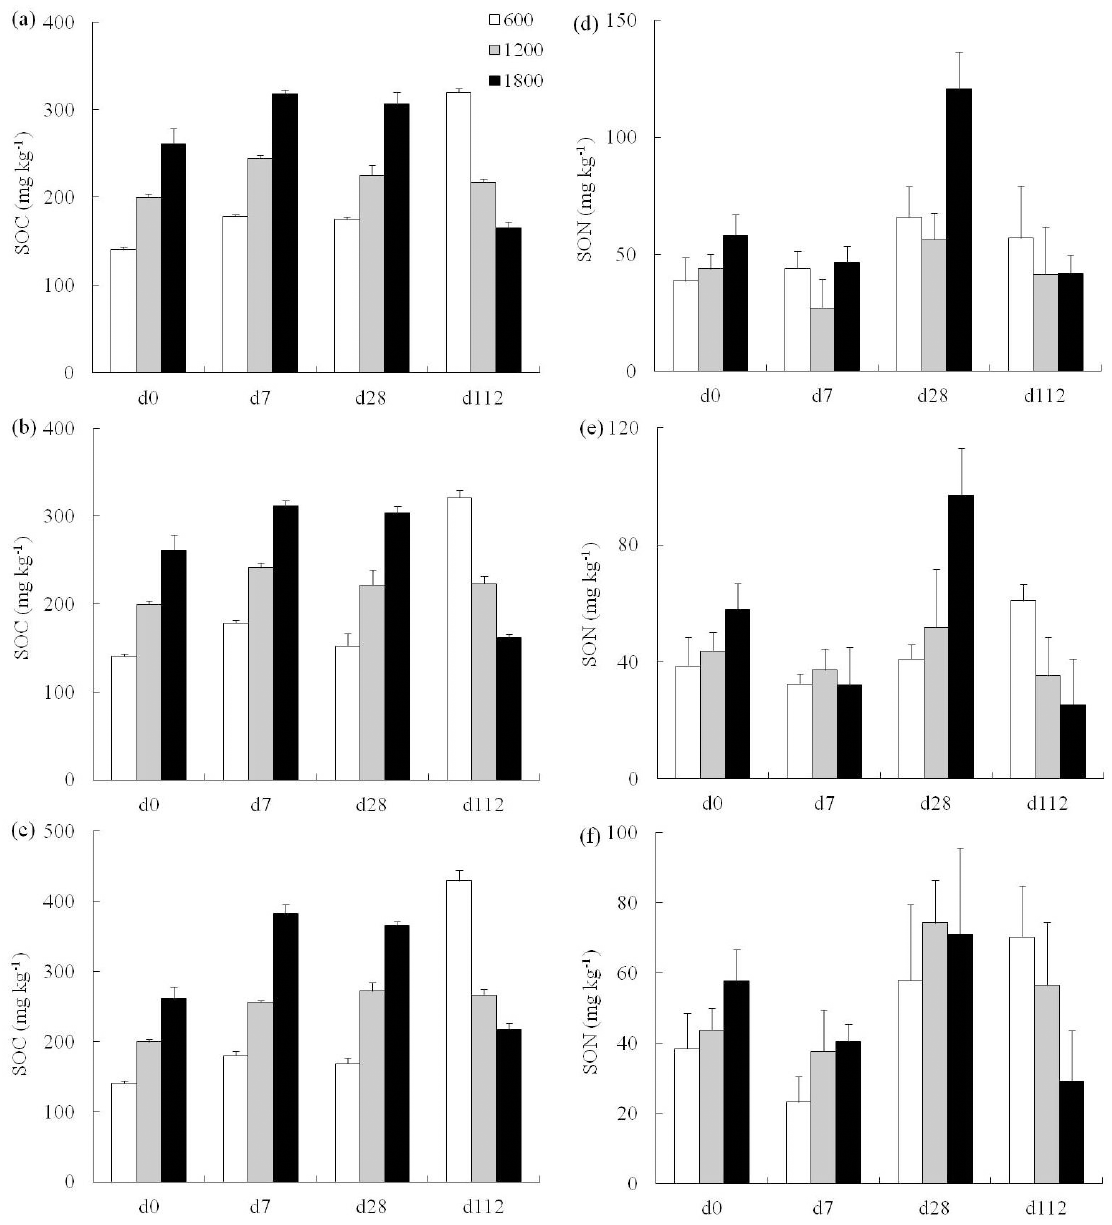
Figure 2. Concentration of (a–c) soluble organic carbon (SOC) and (d–f) nitrogen (SON) in bamboo soils sampled at three elevations and incubated at (a, d) 15 ◦ C, (b, e) 20 ◦ C, and (c, f) 35 ◦ C. Error bars represent standard